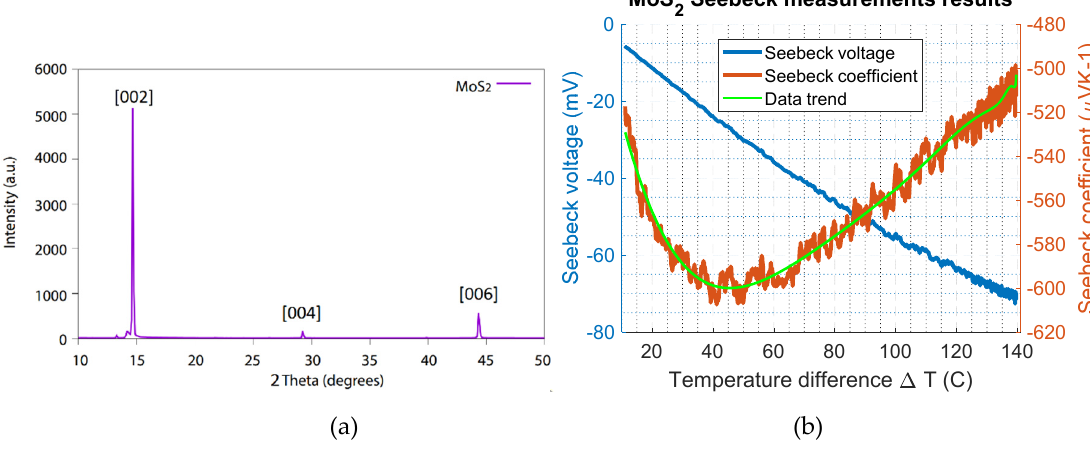
Figure 3. ( a ) XRD measurement data of MoS 2 , the figure showing peaks at 14.7, 29.2 and 44.3 degrees and in ( b ) the Seebeck measurement results are given, the Seebeck coefficient of MoS 2 plotted as a function of the temperature difference on the right y-axis; the Seebeck voltage is given on the left y-axis.